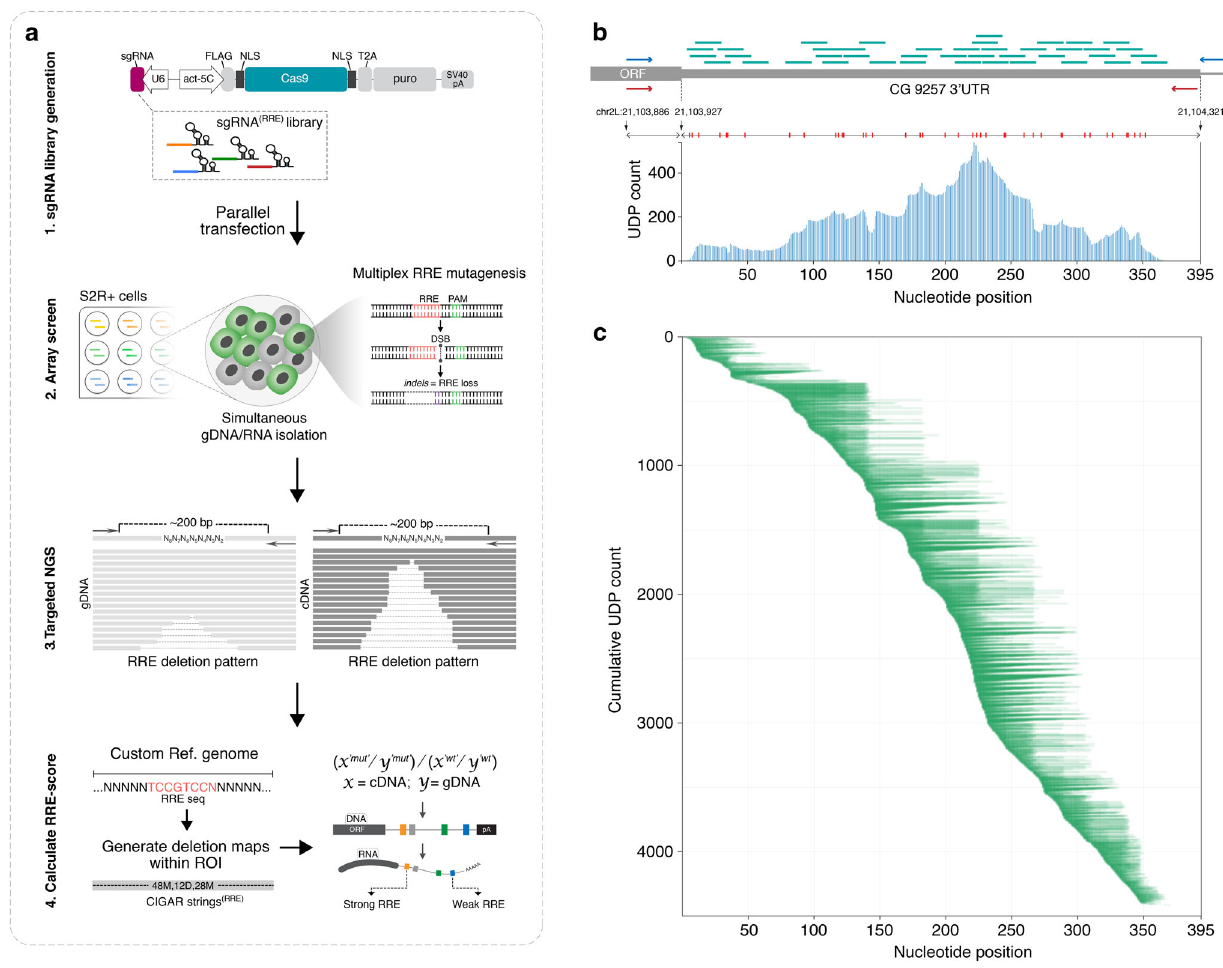
Fig. 2 GenERA-based high-content mutagenesis of a candidate 3 ′ UTR. a Design and implementation of experimental steps underlying GenERA-based parallel functional interrogation of RNA regulatory elements. b Genomic coordinates of CG9257 3 ′ UTR showing the position and distribution of protospacers corresponding to all sgRNAs used to target this region ( green ). Red bars show the position of Sp Cas9 cut site for each sgRNA in the library. The relative locations of gDNA and cDNA NGS library primers are indicated by blue and red arrows respectively. Blue histogram re fl ects the total number of UDPs covering each individual nucleotide across the targeted region. c Coverage and distribution of all UDPs sorted by the position of the fi rst deleted nucleotide and length of deletion. The position of nucleotides across the CG9257 3 ′ UTR is shown on the x axis and the cumulative unique deletions count on the y